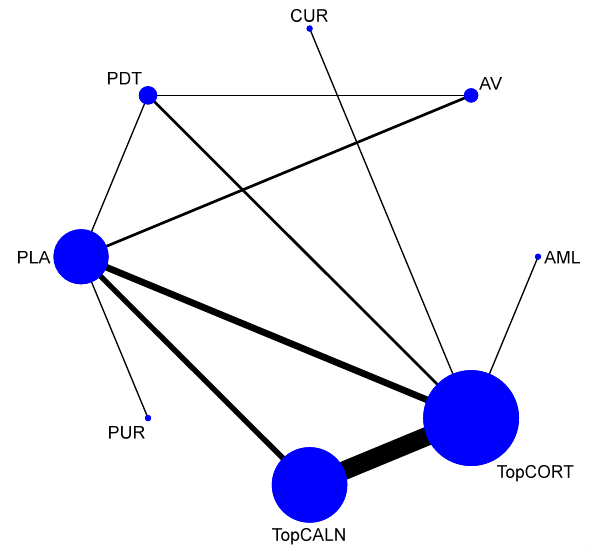
Figure 5. Network plot: Clinical Improvement of Oral Lichen Planus. Abbreviations: AML, amlexanox paste; AV, aloe vera; CUR, curcumin gel; PDT, photodynamic therapy; PLA, placebo; PUR, purslane; SysCORT, systemic corticosteroid; TopCALN, topical calcineurin; TopCALNcoSysCORT, topical calcineurin combined with systemic corticosteroid; TopCORT, topical corticosteroid.